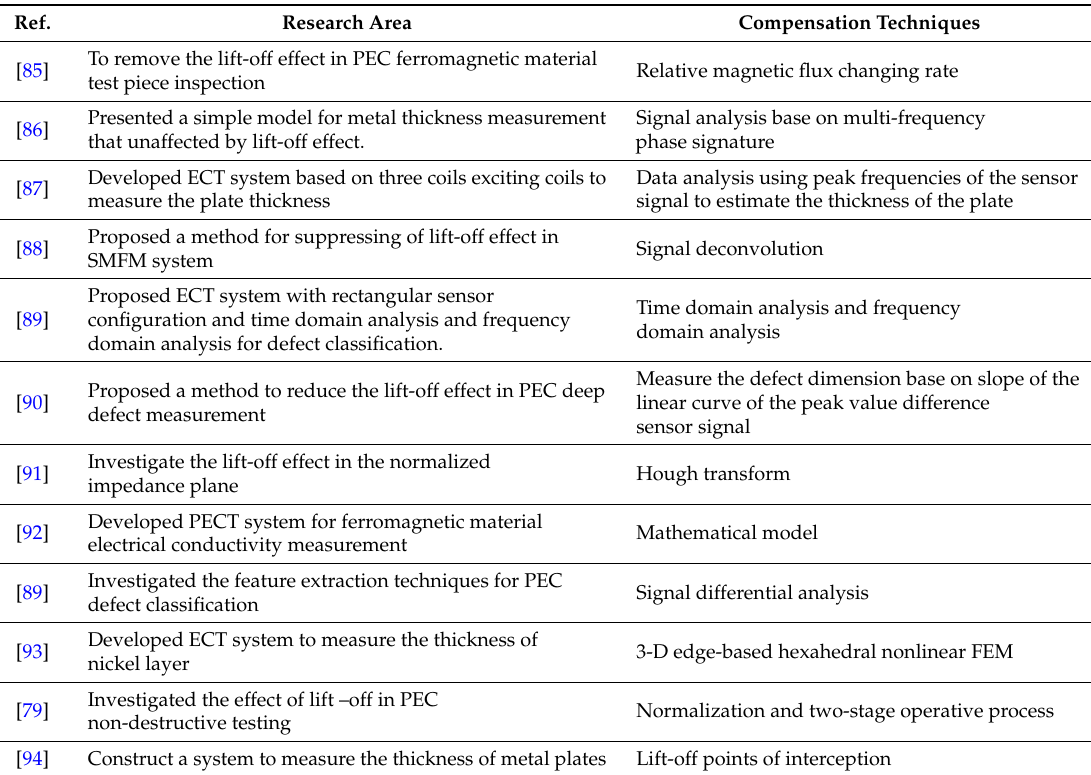
Table 4. Compensation techniques used in eddy current